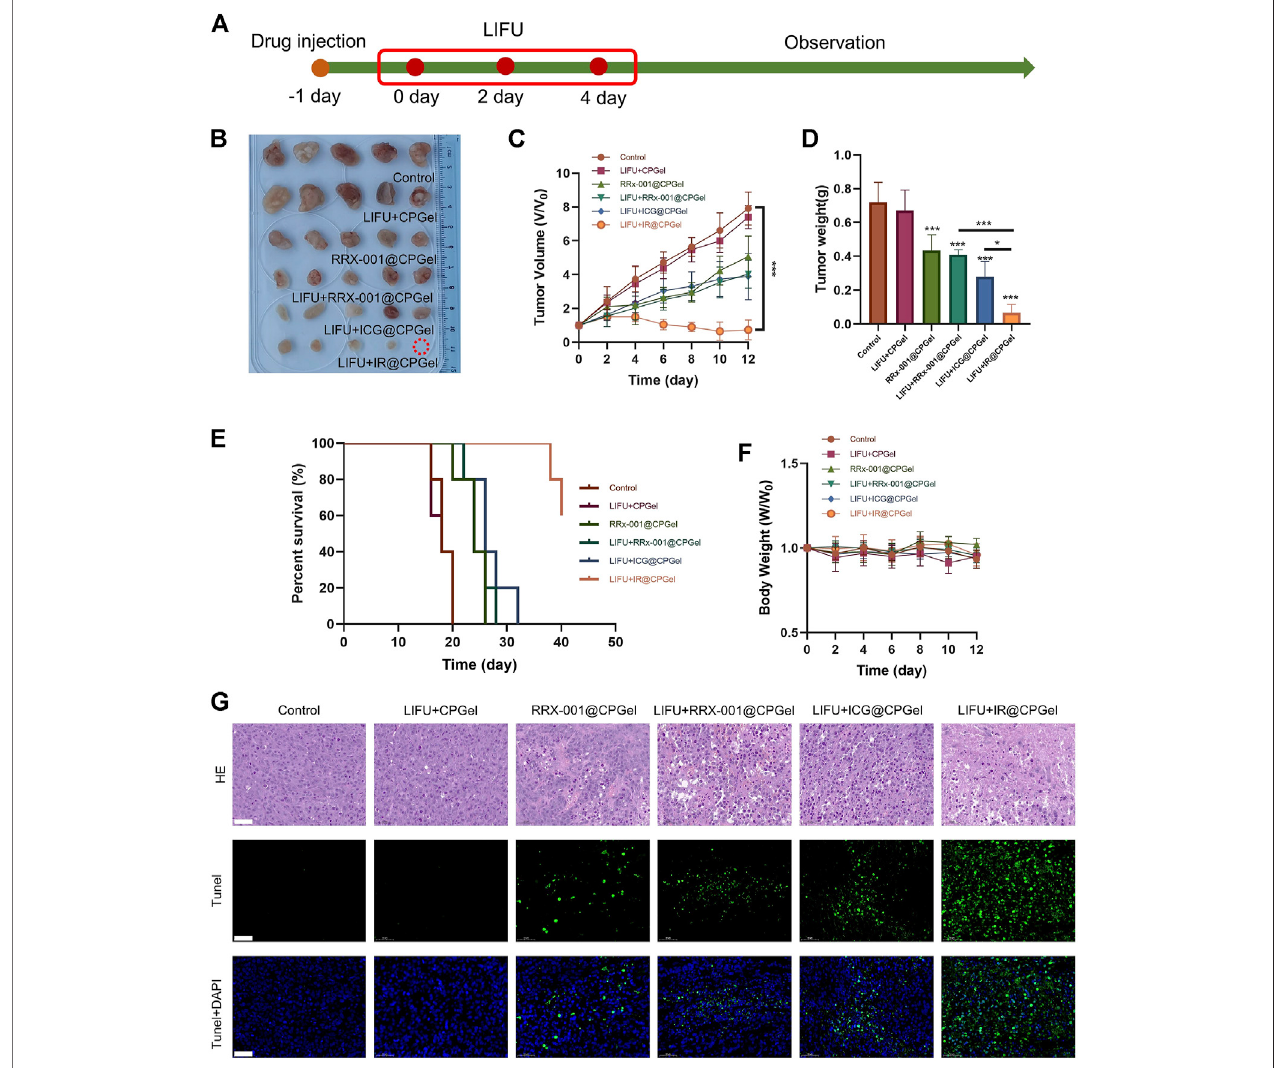
FIGURE 3 | In vivo antitumor ef fi cacy of IR@CPGel. (A) Schematic diagram of the animal experiment; (B) Phots of resected tumors collected from different treatment groups (C) Plot oftumor volume vs. time from different treatment groups; (D) Tumorweightresected from different treatmentgroups; (E) Survivalrate ofmice from different treatment groups; (F) Body weights of mice from different treatment groups; (G) Histological analysis including H&E staining and TUNEL assay of tumor tissues from different treatment groups, scale bar = 50 µm. All data are shown as the mean ± SD. (n = 5), p p < 0.05 and ppp p < 0.001 vs. Control.